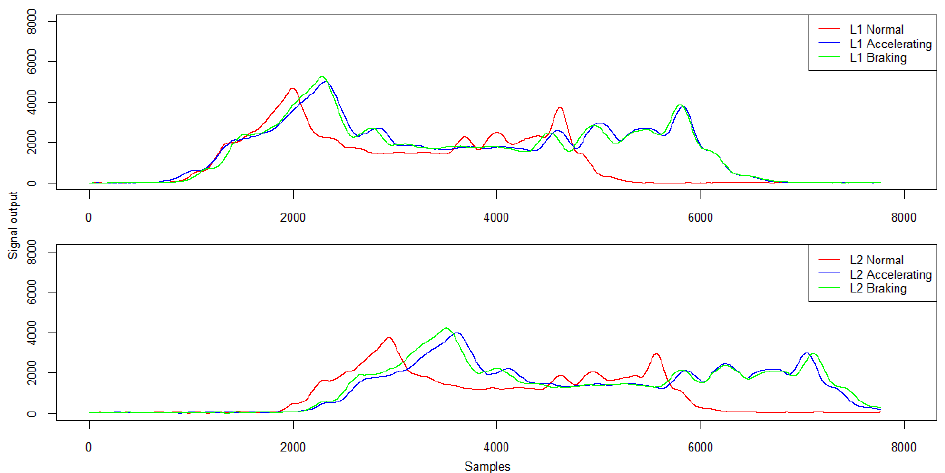
Figure 22. Example signals from the induction loops at constant speed, acceleration and braking— five-axle vehicle. Table 11. Signal characteristics from inductive loops—amplitude and mean signal value (ADU).